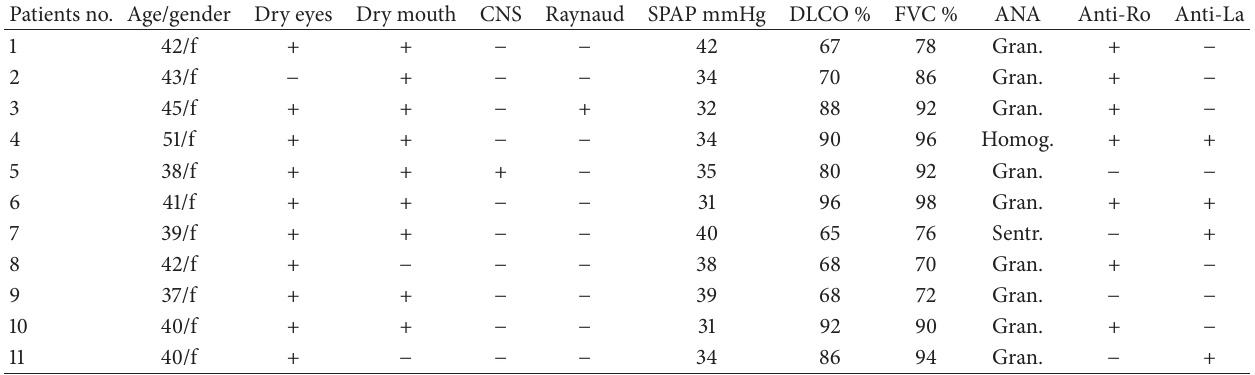
Table 1: Clinical and laboratory findings of 11 patients with pulmonary artery hypertension.